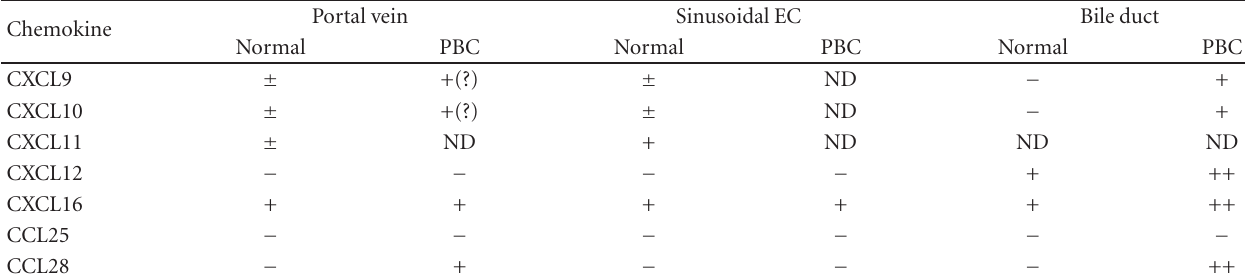
Table 1: Chemokine expression patterns in the portal tract, sinusoidal endothelium, and bile duct of normal and PBC liver. Chemokine